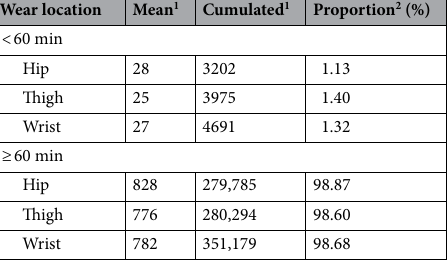
Table 2. Overview of non-wear episodes grouped in short and long non-wear episodes. 1 Aggregated in minutes. 2 Proportion of total non-wear time by wear location.